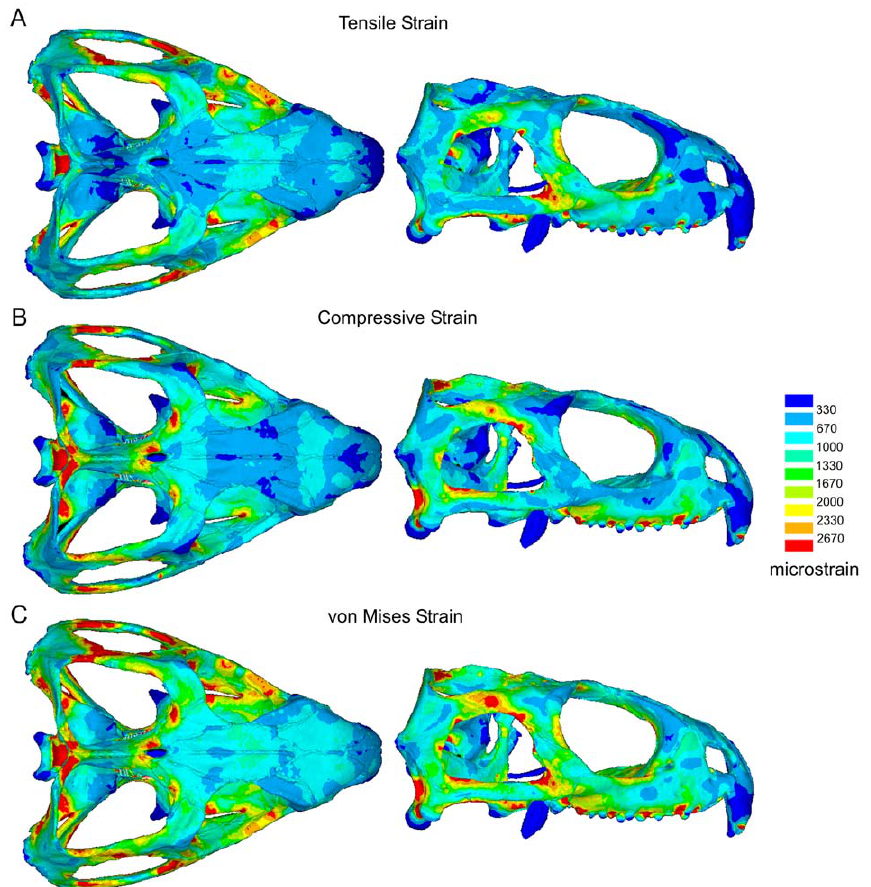
Figure 7. Combined loading tensile, compressive, and von Mises strain plots. Peak combined loading A. tensile, B. compressive, and C. von Mises strain